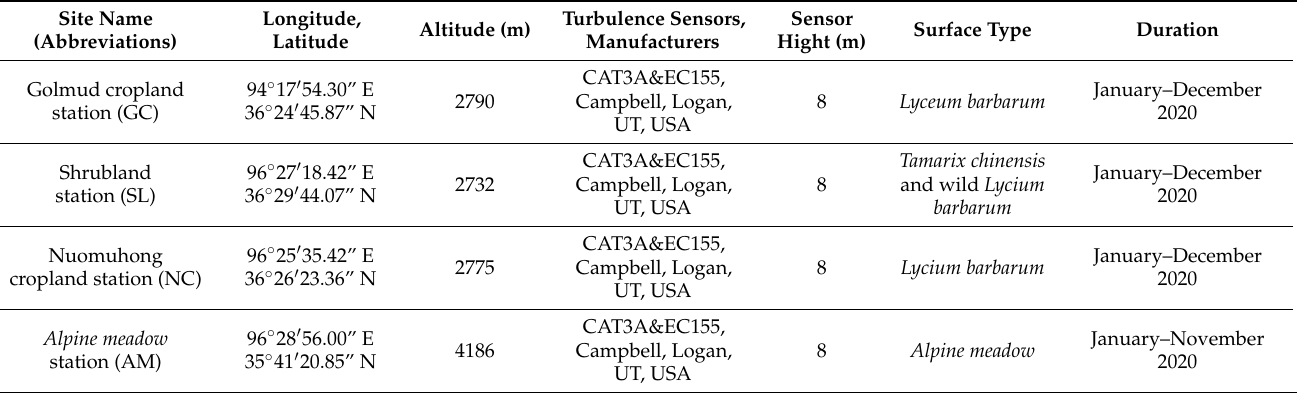
Table 1. Information of 4 observation stations and instruments in Qaidam Basin in